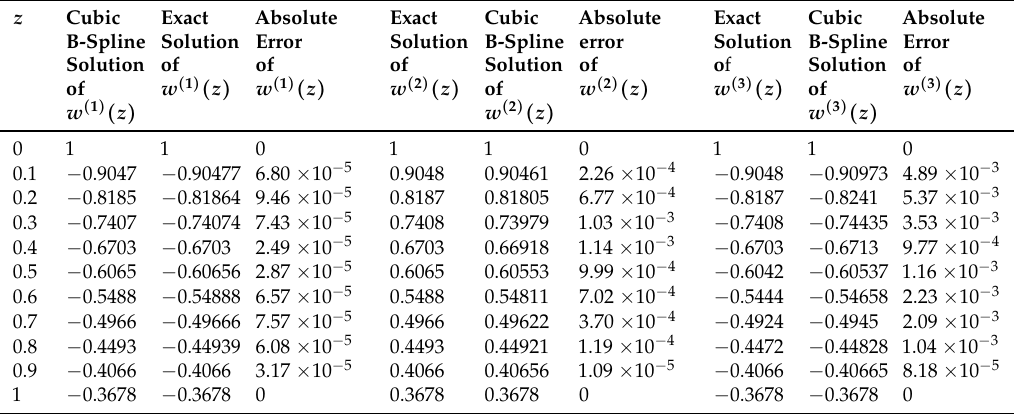
Table 19. Absolute errors at all derivatives at h = 1 Problem